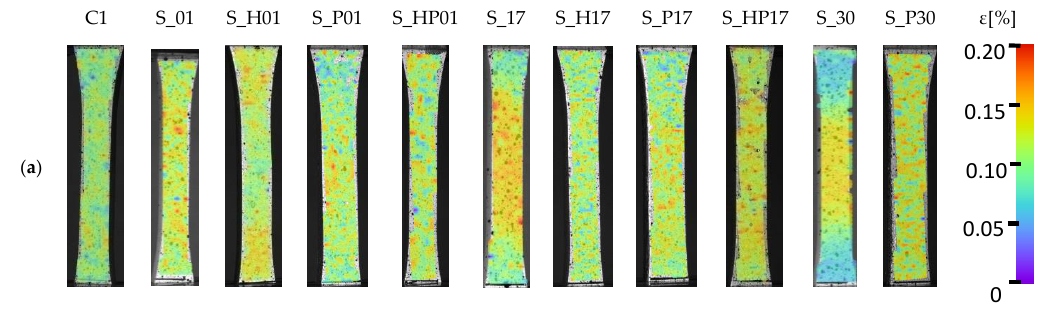
Figure 4. Strain-stress curves for S_01, S_17, and S_30 samples after different types of heat treatment with the additional course of conventionally made